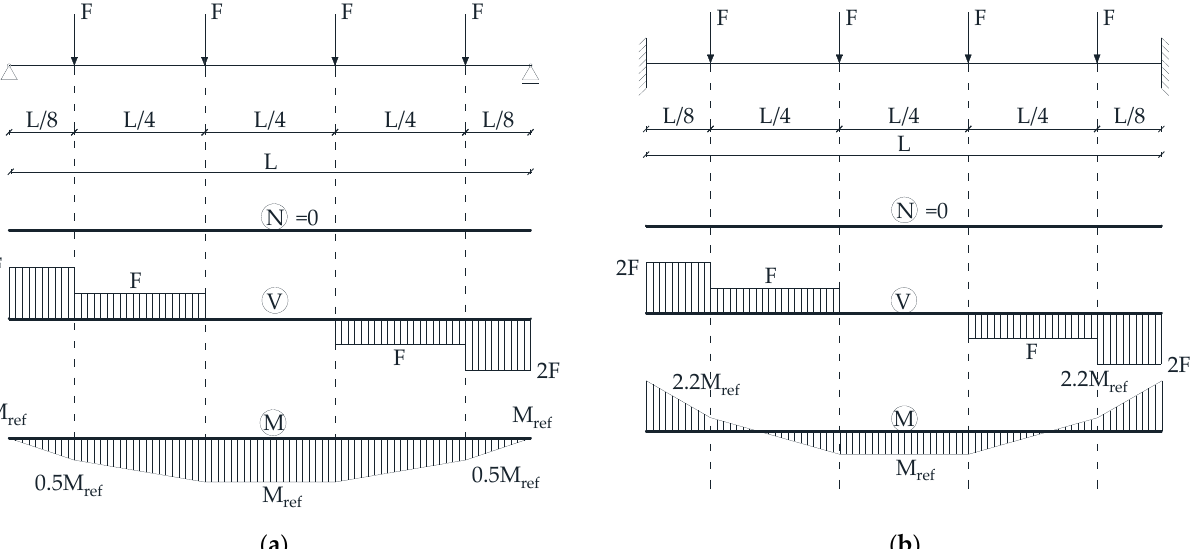
Figure 11. FE model in ABAQUS/CAE with the definition of 2 SW and 3 SW configurations. According to [56,58], the beam loading was defined as a vertical displacement in a set of multipoint constraints (MPC) that forms a leverage system to transmit the deflection to the four loading points, see Figure 11. A kinematic coupling constraint defined the link between the control points and the pressure elements for all DOFs. RB3D2 elements were used as a rigid body for load transfer and multipoint constraint beam (MPC beam) for DOF coupling between groups of specified nodes. The total force, 4F, is obtained by monitoring the reaction force on the node where vertical displacement is applied. Due to the complicated geometry and multiple contact interactions between different components, the “explicit” solving method was utilised to avoid the numerical convergence difficulties, which is often encountered in the “implicit” solving method. The loading speed is defined by ramping up the velocity smoothly over the analysis step. To increase the speed of performed analyses, loading velocity is increased, ensuring minimal inertia effects. This is ensured by maintaining kinetic energy at a small value throughout the analyses (mainly below 5% of all energy) and by limiting loading velocity to less than